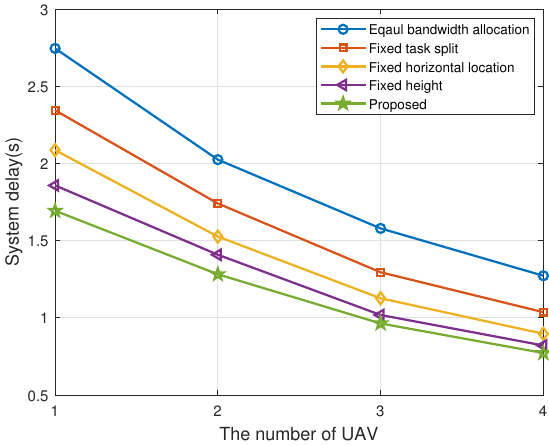
Figure 7. System delay with different number of UAVs.